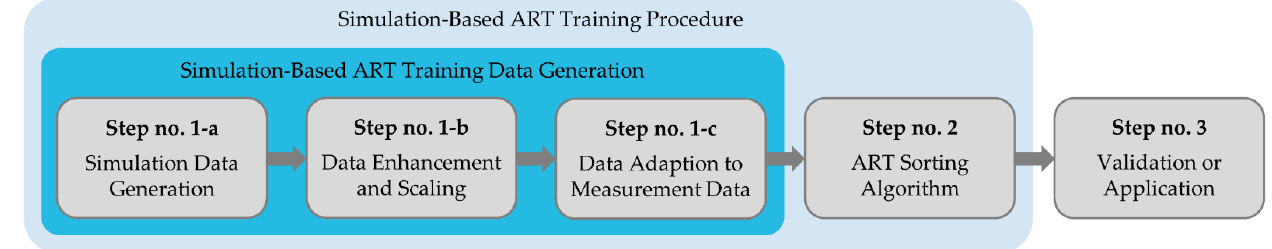
Figure 1. Overview of our strategy including a simulation-based ART training data generation and the subsequent training procedure aiming to build a specific ART sorting algorithm.